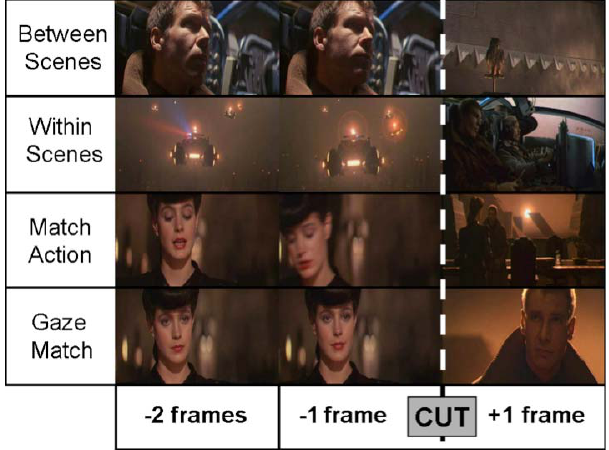
Figure 1: Examples of the four categories of cuts compared in this study: Between Scenes (no continuity; top row), Within Scenes (scene continuity; second row), Match Action (scene and action continuity; third row), and Gaze Match (scene and gaze continuity; bottom row). All images are taken from Blade Runner (Ridley Scott, 1982) and depict the two frames prior to the cut and the frame immediately after the